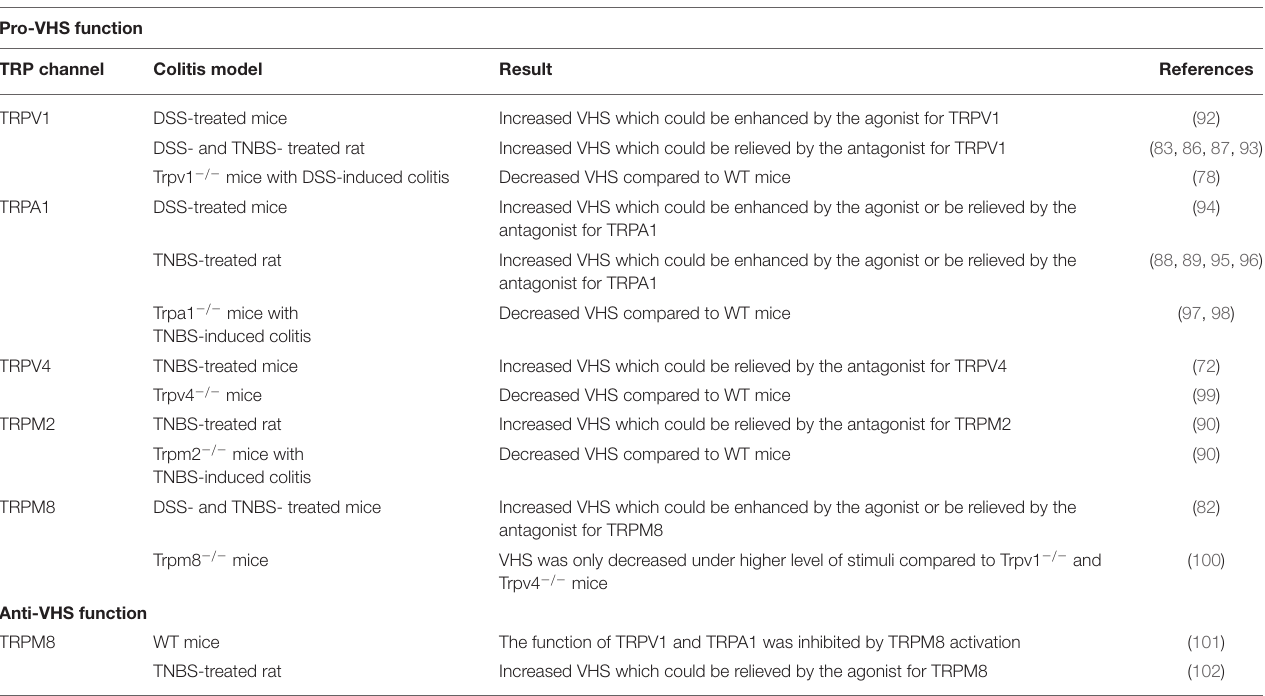
TABLE 2 | The function of TRP channels in VHS of colitis